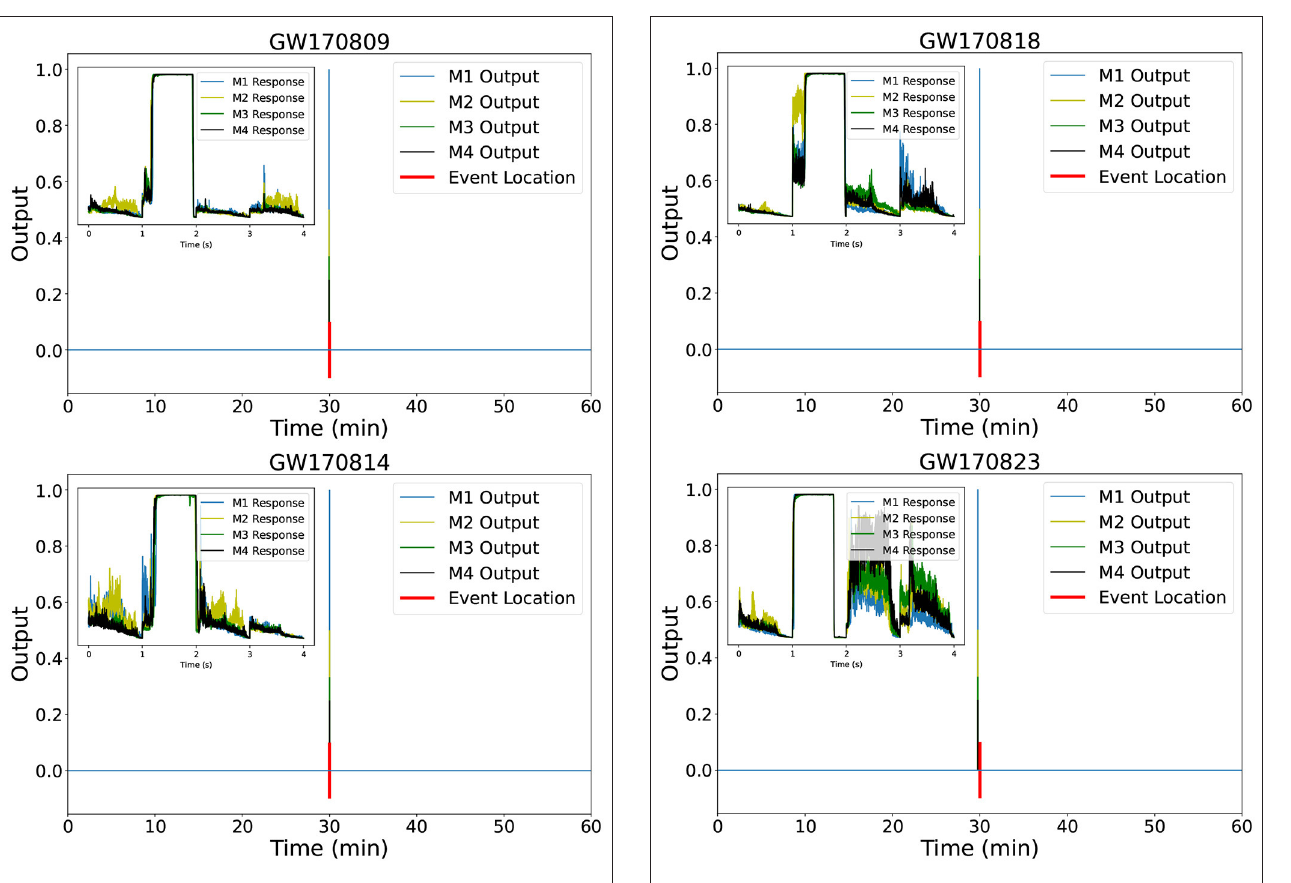
FIGURE 3 | Event detection. Output of the 4 individual AI models in our ensemble upon processing 1 h long advanced LIGO data that contains the events GW170809 (top) and GW170814 (bottom). The insets in both panels show the distinct, sharp response that is common among all AI models when they identify a real signal.